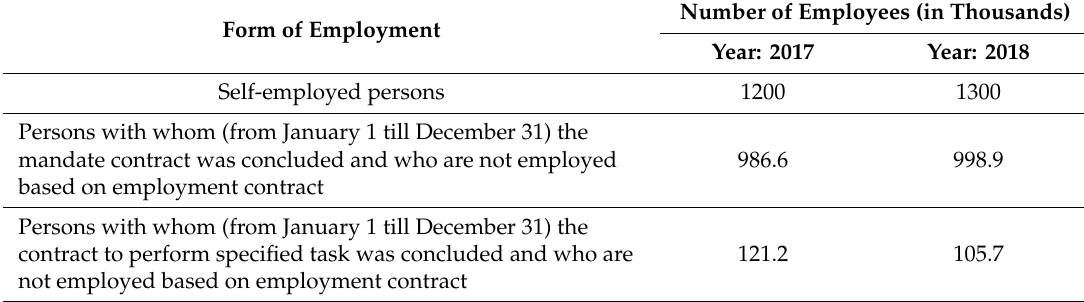
Table 1. Number of employees performing non-standard forms of employment—data provided by Statistics Poland (Statistics Poland